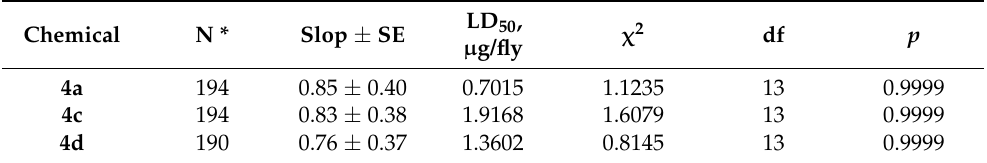
Table 2. Median lethal dose (LD 50 ) of phthalimide derivatives ( 4a , 4c and 4d ) for the control of the adult female Caribbean fruit fly, A. suspensa , under the laboratory